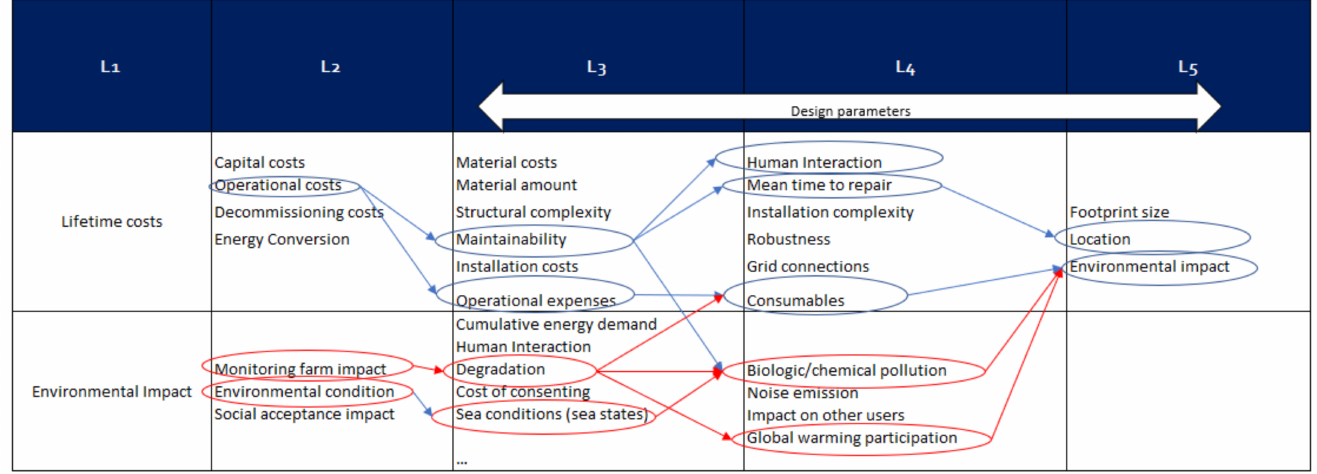
Figure 7. Example of using the solution hierarchy to identify relevant functional requirements from the high-level energy trilemma to meet customer requirements through specific design